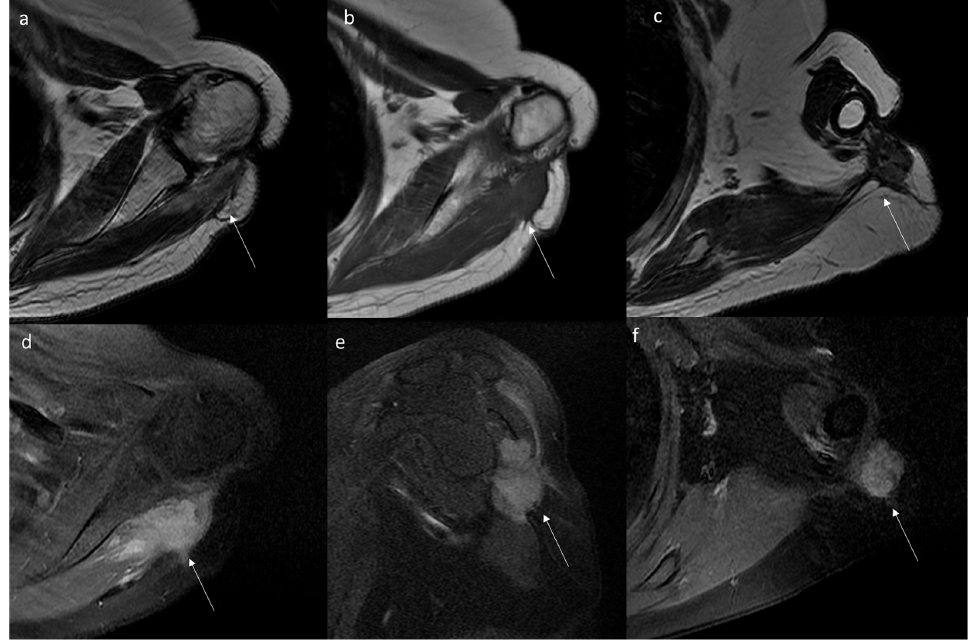
Figure 4. Aggressive fibromatosis of the shoulder within the muscular and fascial planes of the supraspinatus and deltoid muscles depicted (arrows) on axial T2 ( a ) and T1 ( b , c ) sequences and after gadolinium ( d – f ).